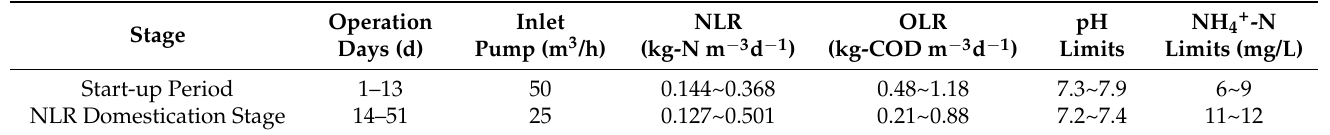
Table 2. Operating conditions at different stages.